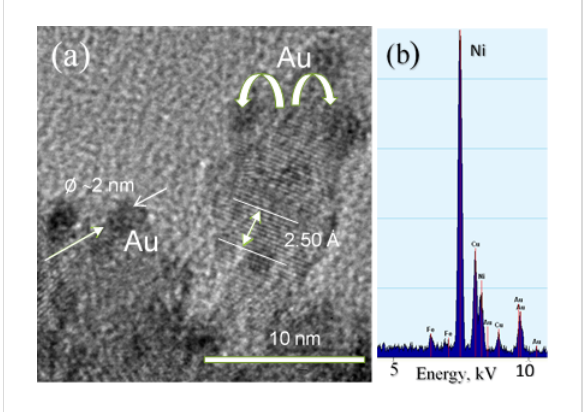
Figure 2: HRTEM image of CoFe 2 O 4 @Met NPs after sonication in 15 mmol·L − 1 HAuCl 4 solution at 37 °C for 4 h (a) and their EDX spec- trum